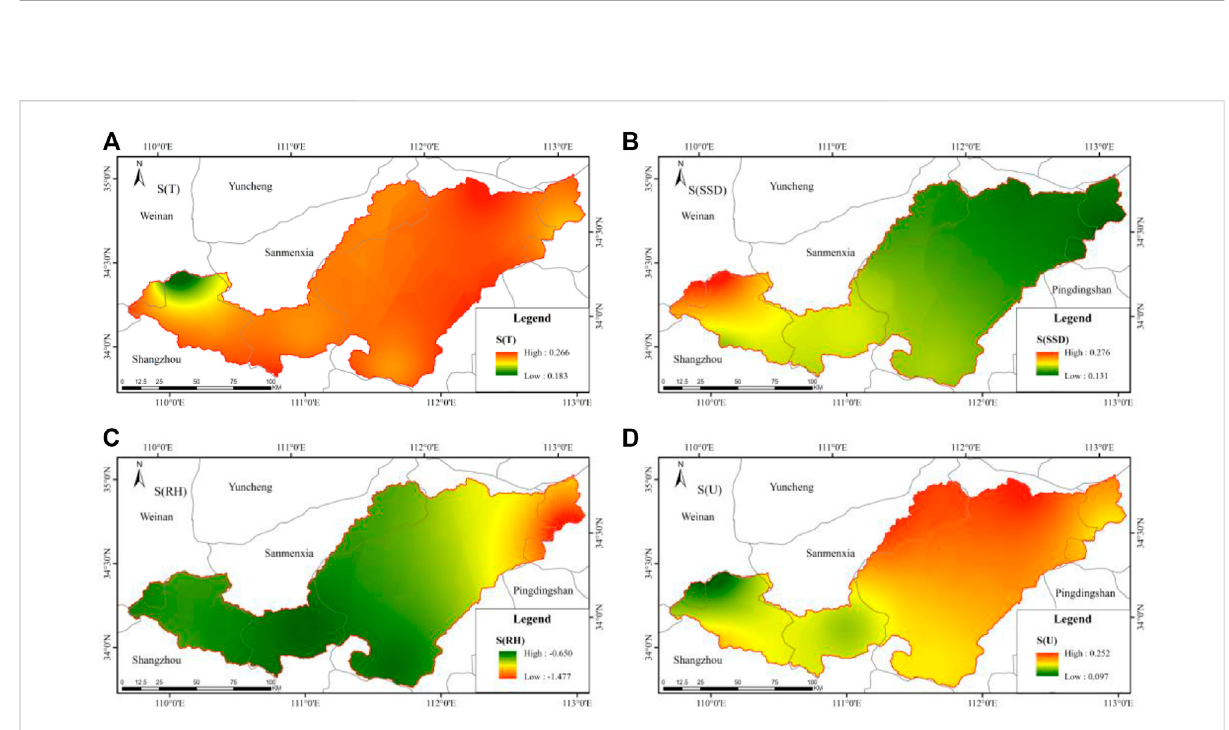
Spatial distribution of the sensitivity coef fi cients: (A) the distribution of S(T); (B) the distribution of S(SSD); (C) the distribution of S (RH); (D) the distribution of S(U).